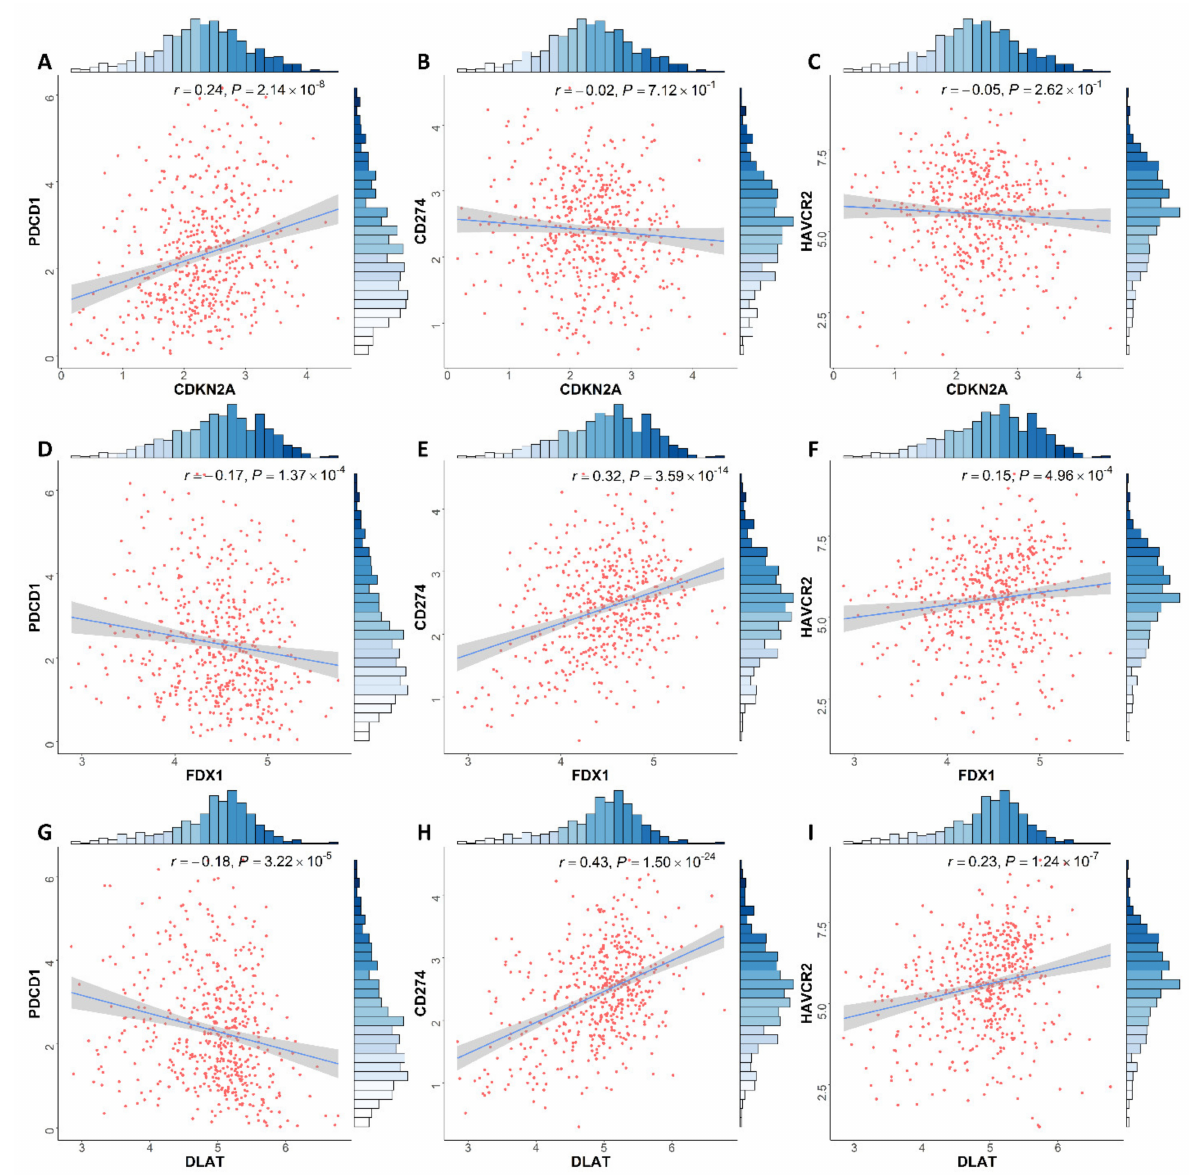
Figure 7. Association between ( A – C ) CDKN2A , ( D – F ) FDX1 and ( G – I) DLAT and PDCD1 , CD274 and HAVCR2 expression in ccRCC patients, respectively. ccRCC: clear cell renal cell carcinoma. 3.7. Differential Expression of CRGs in Different Pathologic Stages and Histological Grades of